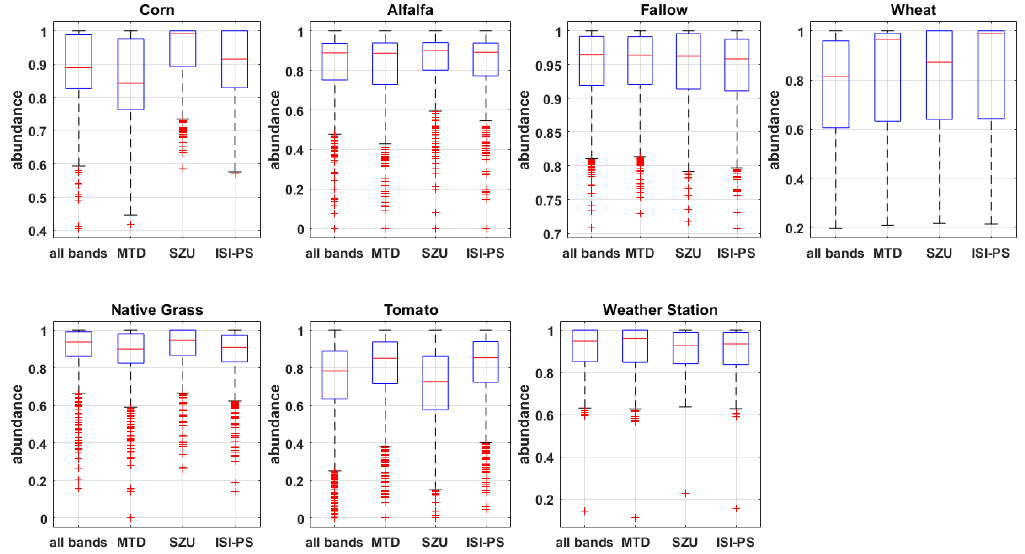
Figure 15. The box plot of the resulting fractions for each class using the selected bands by the studied method, using: (1) all bands; (2) MTD bands; (3) SZU bands; and (4) ISI-PS bands. In this experiment, the threshold value of the correlated bands was considered as 1.25 degrees.